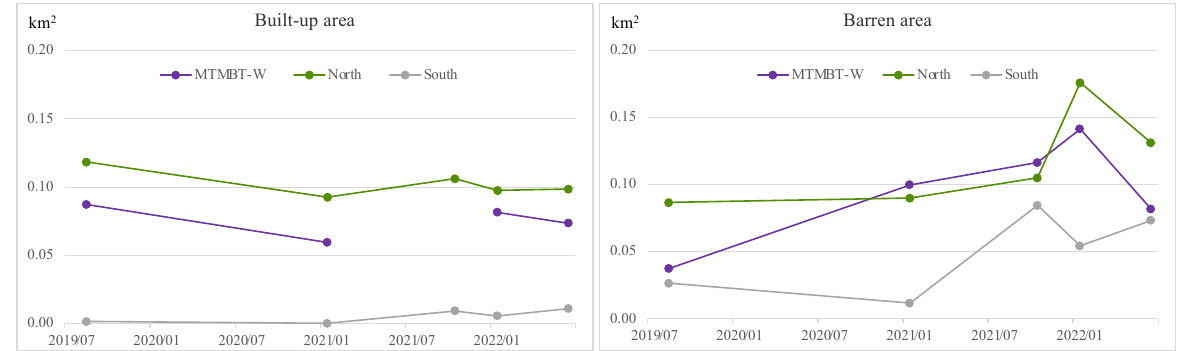
Figure 5. Built-up and barren extent transformations by